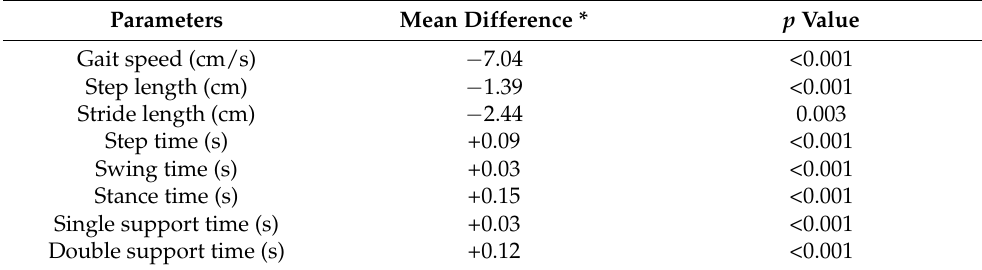
Table 5. Comparison of gait parameters between single-task and